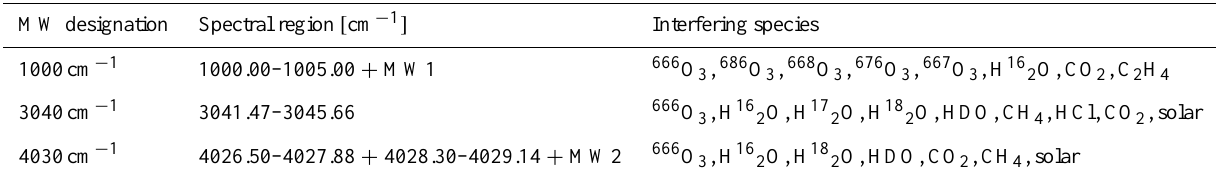
Figure 1. Example of simulated transmission spectra of most abundant ozone isotopologue, 666 O 3 (upper panel, green solid line), and the measured transmission spectra (blue solid line), simulated spectra (red dashed line), and residuals (black solid line) for the 1000, 3040, and 4030 regions and for typical measurement conditions of the Izaña spectrometer 120 / 5HR (25 October 2010) (bottom panel). The dotted grey lines enclose the spectral regions with less weight in the ozone retrieval. Note that the 666 O 3 transmission spectra has been multiplied by a factor of 2 and 10 for 3040 and 4030cm − 1 regions, respectively. Table 1. Spectral regions and interfering species considered in the FTIR ozone retrievals. MW1 stands for additional microwindows contain- ing well-isolated CO 2 lines allowing for a temperature fit: 962.80–963.80, 964.25–965.25, 967.20–968.20, and 968.20–969.60cm − 1 ; MW2 stands for an additional microwindow with CH 4 lines: 4210.40–4211.70cm − 1